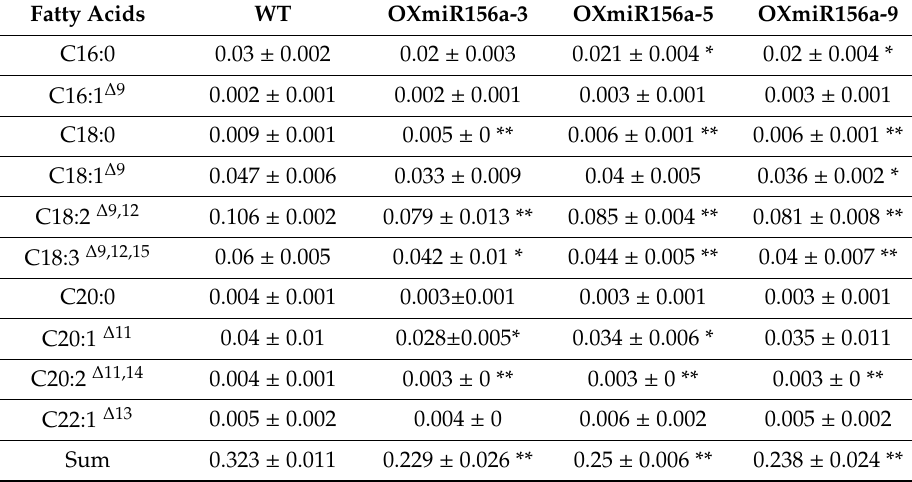
Table 3. Fatty acids profiles of Arabidopsis seeds over-expressing Lus-miR156a.